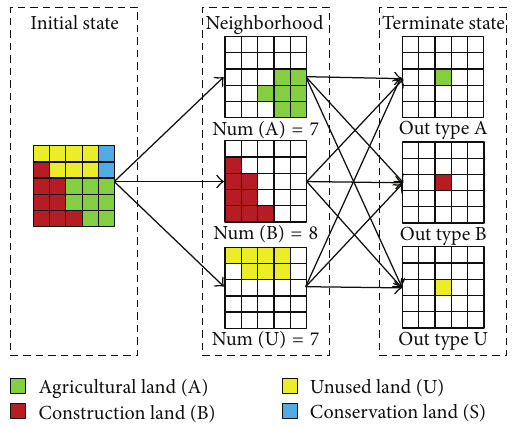
Figure 3: Multitarget land use change in